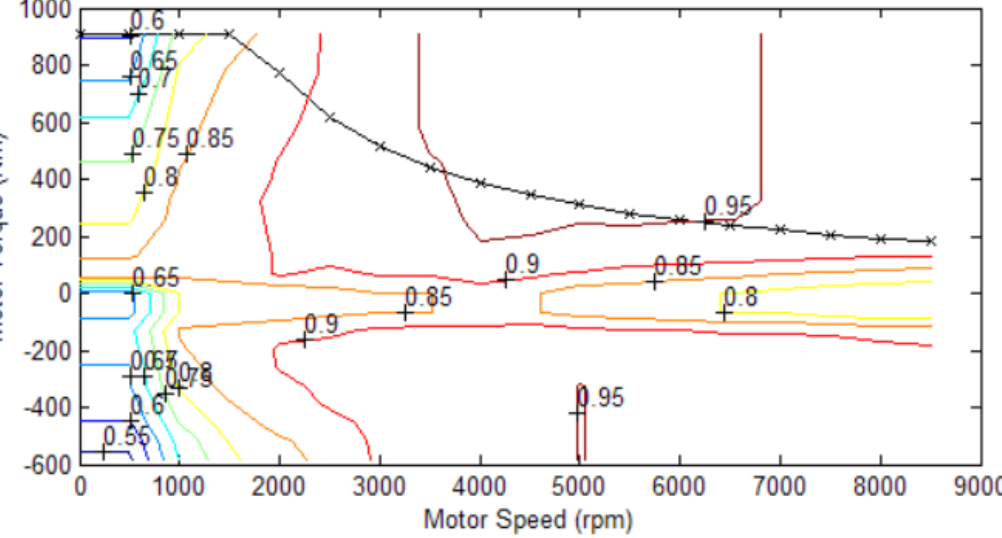
Figure 7. Motor torque diagram.